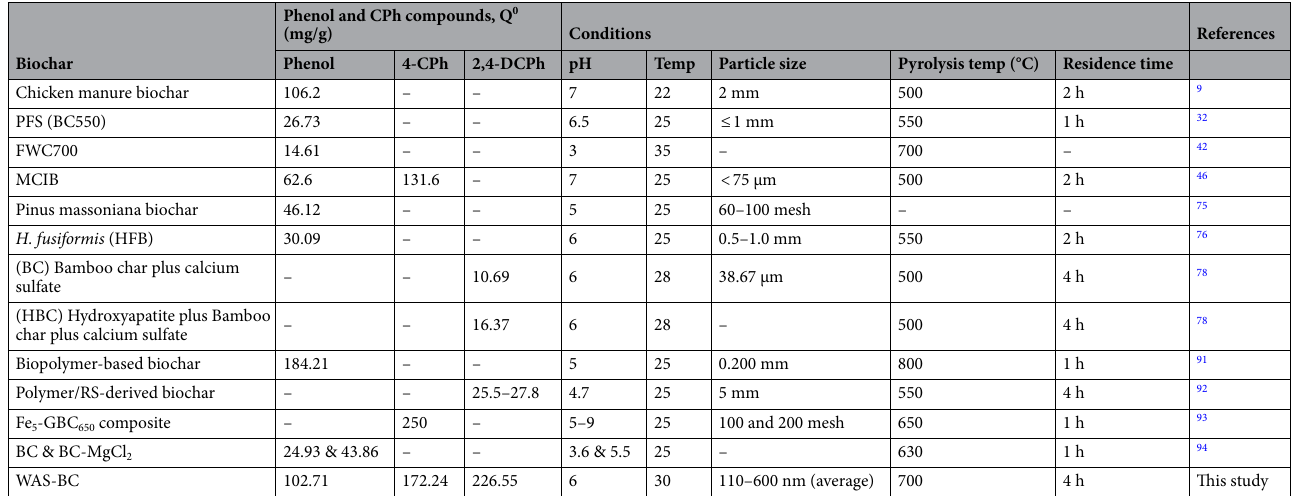
Table 5. The maximum uptake capacities Q 0 (mg/g), biochar derived from different biomass and the remediation process of phenol and CPhs compounds from aqueous